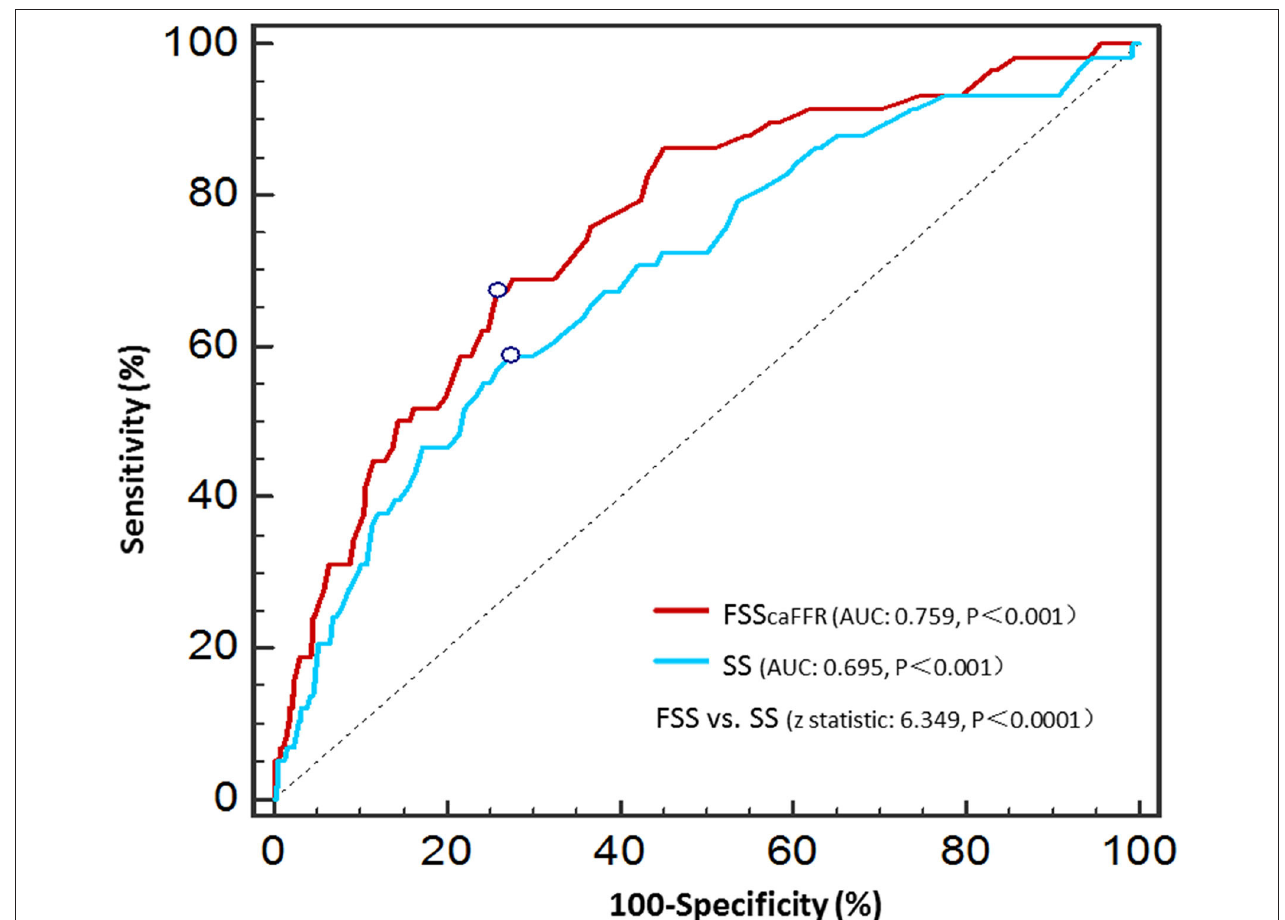
FIGURE 2 | Receiver operator characteristic curves of the SS and FSS caFFR